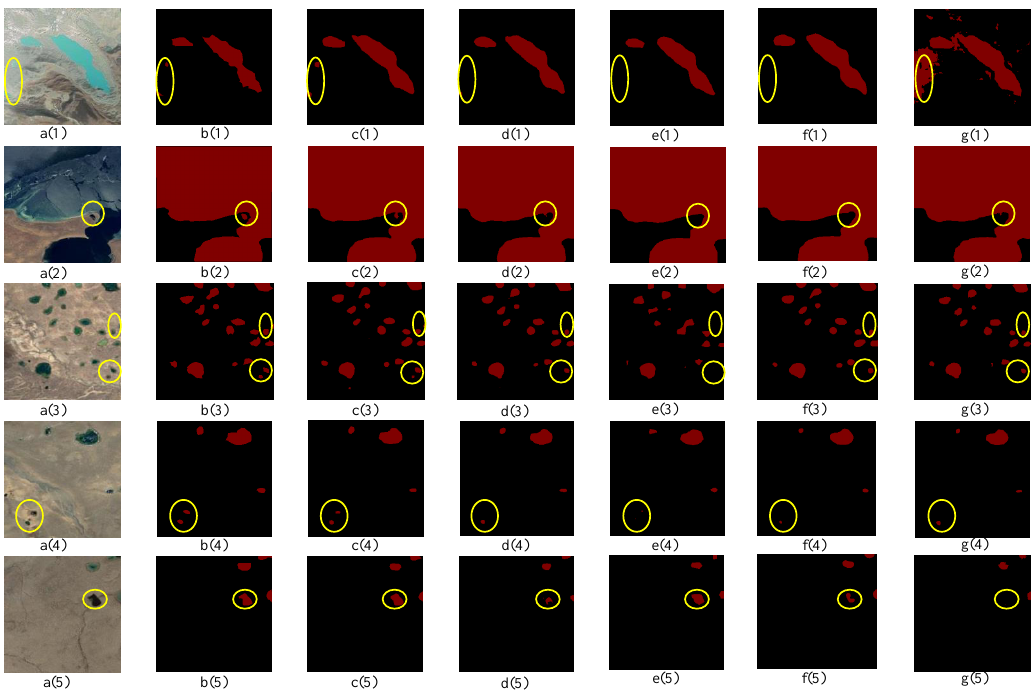
Figure 7. Performance comparison of different models for small lake water extraction. ( a(1) – a(5) ) are the raw images in the test set; ( b(1) – b(5) ) are the ground truths to which the raw images correspond; ( c(1) – c(5) ), ( d(1) – d(5) ), ( e(1) – e(5) ), ( f(1) – f(5) ), and ( g(1) – g(5) ) are the extracted results of